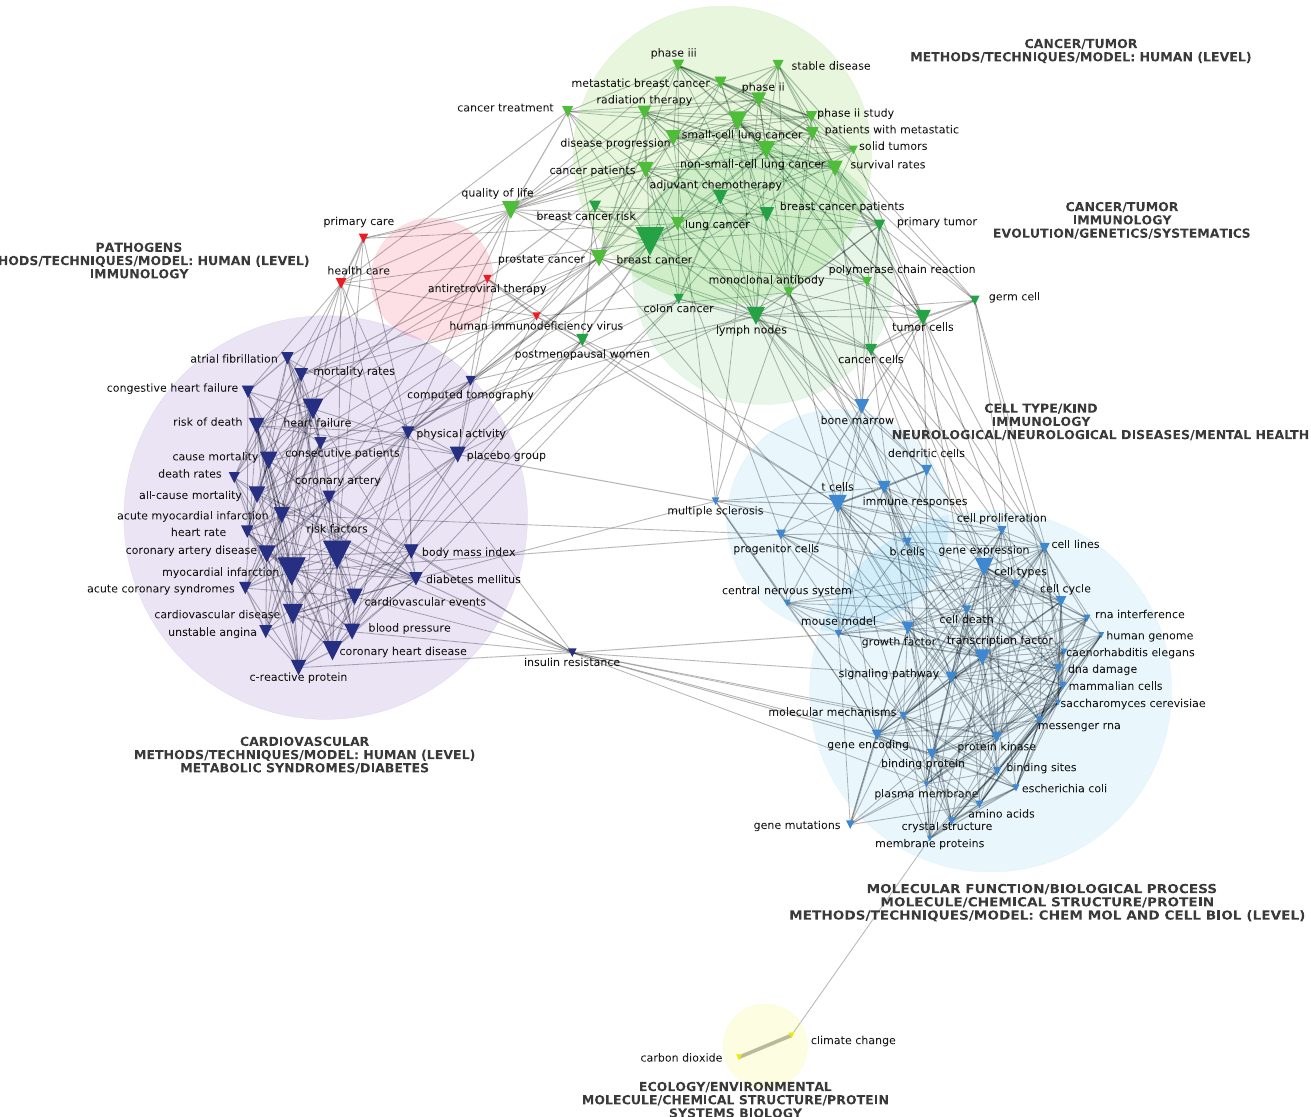
Fig 3. Top 100 HBMS research multi-terms (1999 to 2008) plotted according to co-occurrence using a chi-squared distribution. Source: Authors’ analysis based on WoS data extraction plotted via CorTexT.